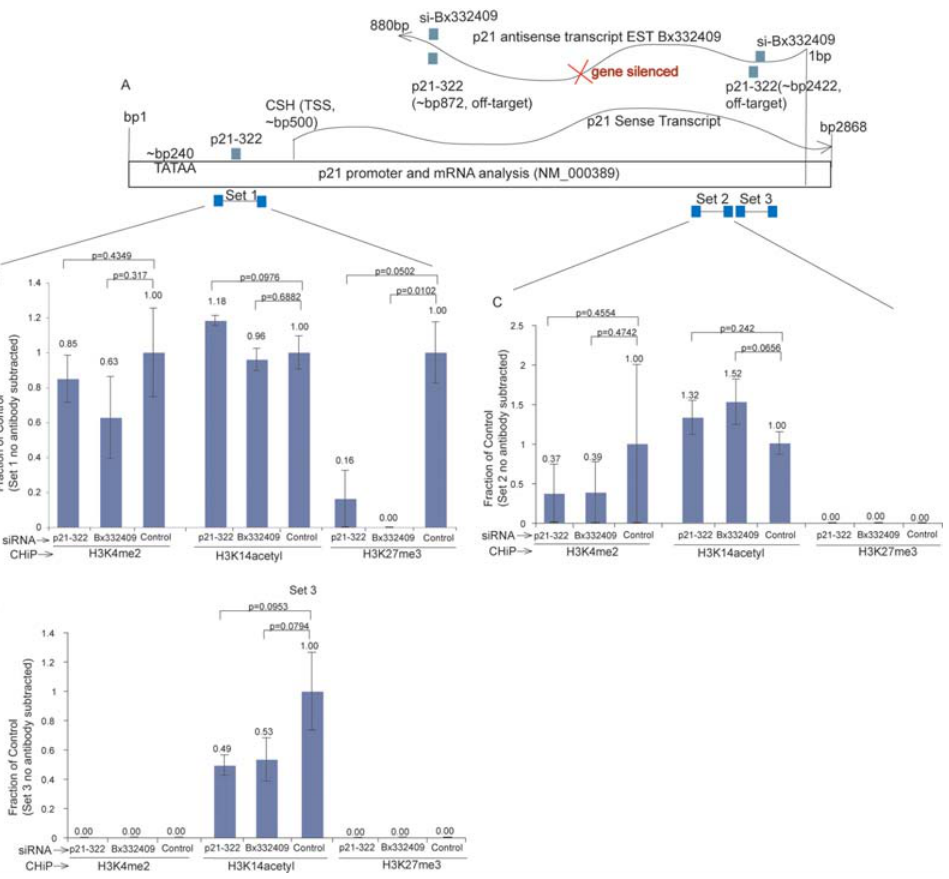
Figure 2. Suppression of p21 antisense transcription results in a loss of suppressive H3K27me3 epigenetic mark at the p21 promoter. The activating marks (H3K4 and H3K14) and the suppressive mark H3K27me3 were assessed by ChIP analysis in p21-322 and Bx332409 siRNA treated cells. (A) Schematic of the various p21-322 and Bx33409 siRNA target loci as well as primer sets (sets 1–3) used in the subsequent ChIP analysis are shown. The results from duplicate siRNA transfected cultures are shown with primer sets spanning (B) the p21-322 promoter target site (Set A), (C) in the coding region of p21, and (D) spanning the p21-322 and Bx332409 targeted site in the p21 mRNA. The standard error of the means is shown for quadruplicate measurements of the duplicate transfected cultures and the respective p values from paired T